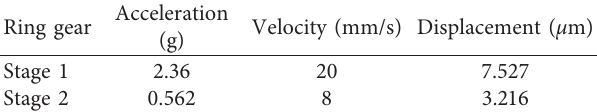
Table 4: Vibration RMS of the ring gear.